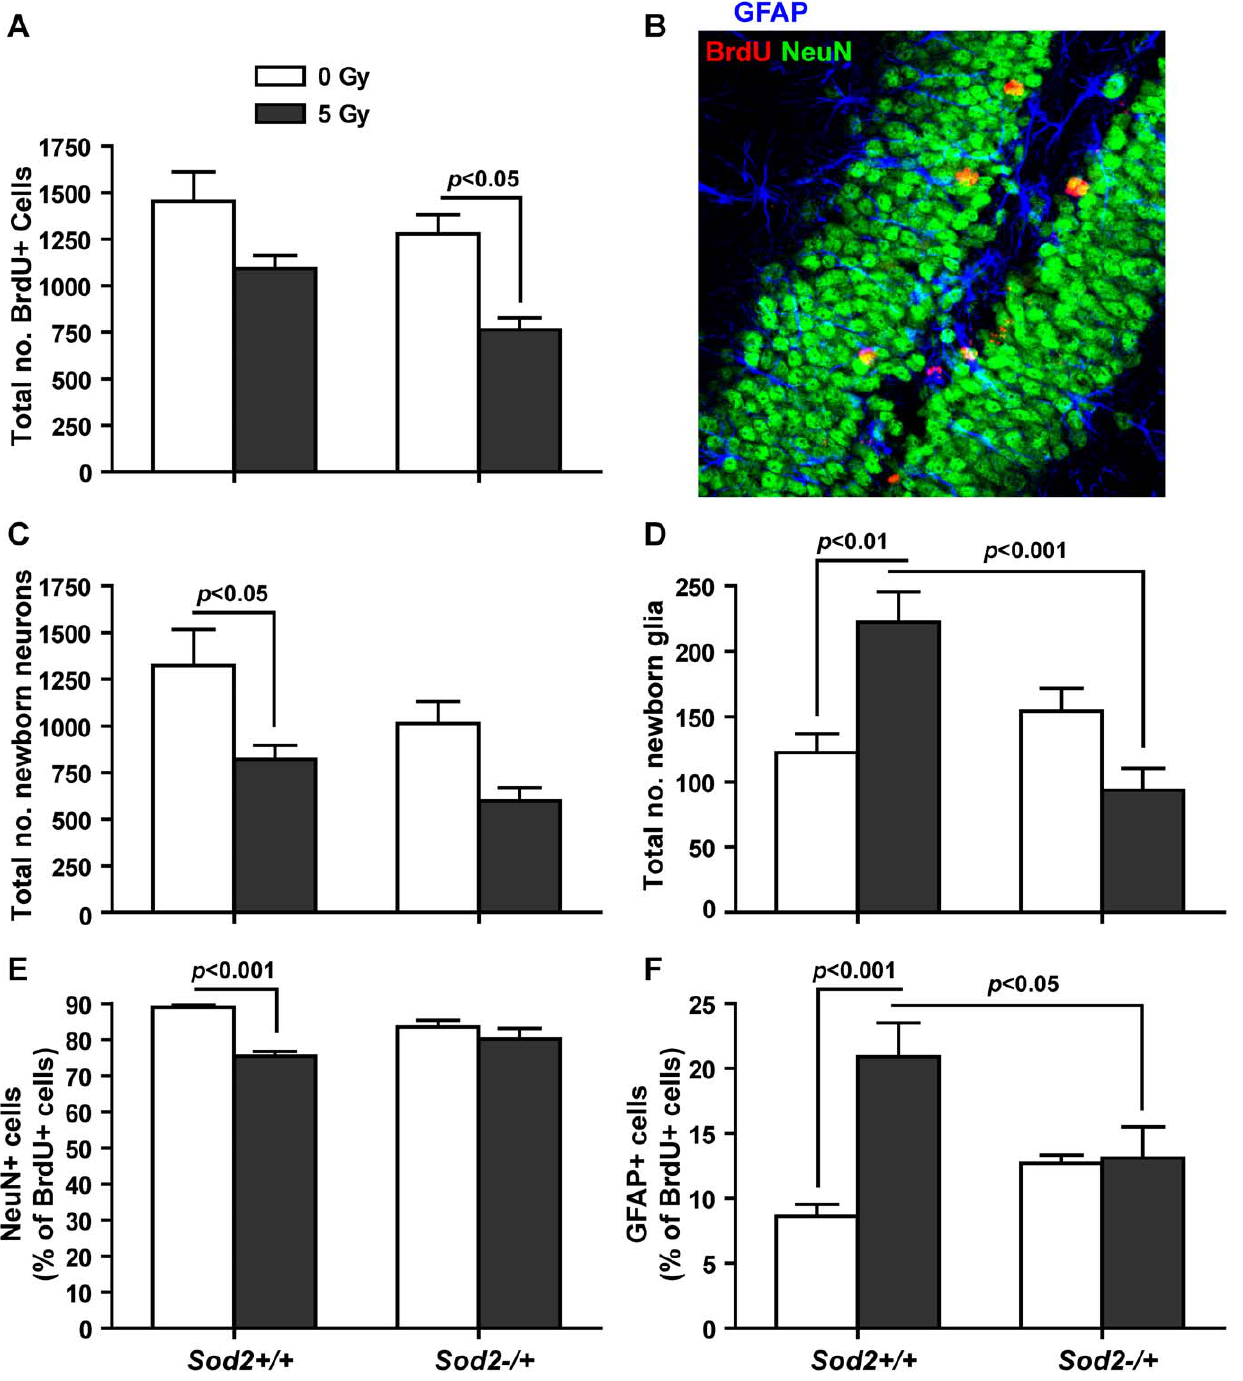
Figure 3. Long-term survival of newly generated cells in the SGZ following behavioral studies. A, total number of BrdU + cells in the SGZ. Sod2 genotype ( F (1,23) =4.71, p=0.041) and radiation treatment ( F (1,23) =14.28, p=0.001) both contributed significantly to variations in BrdU numbers, but there was no interaction between genotype and treatment ( F (1,23) =0.44, p=0.52). B, a representative image showing BrdU + /NeuN + and BrdU + / GFAP + cells in the SGZ of the dentate gyrus. C, the total number of newborn neurons. Genotype ( F (1,16) =4.66, p=0.046) and treatment ( F (1,16) =13.76, p=0.0019) both contributed significantly to variations in BrdU + /NeuN + numbers, but there was no interaction between these two factors. D, the total number of newborn glial cells. Only genotype ( F (1,16) =6.97, p=0.018) contributed significantly in the data variation, and there was an interaction between genotype and treatment ( F (1,16) =19.05, p=0.0005). E, the percentage of newly born neurons. Only treatment ( F (1,16) =19.80, p=0.0004) contributed significantly to the data variation, and there was an interaction between genotype and treatment ( F (1,16) =7.30, p=0.0157). F, the percentage of newly born glial cells. Only treatment ( F (1,16) =11.79, p=0.0034) contributed significantly to the data variations, and there was an interaction between genotype and treatment ( F (1,16) =10.27, p=0.0055). Data are presented as mean 6 SEM. Sample size (in the order of Sod2 + / + / 0 Gy, Sod2 + / + /5 Gy, Sod2 2 / + /0 Gy, and Sod2 2 / + /5 Gy): BrdU, n=8, 6, 7, and 6; BrdU + /NeuN + and BrdU + /GFAP + , n=5 each.